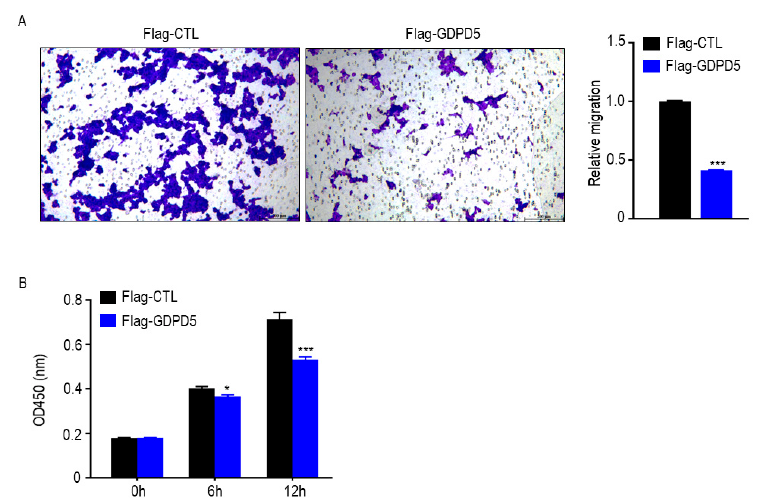
Figure 7. GDPD5 affects the migration and proliferation of human neuroblastoma cell line SH-SY5Y. ( A , B ) GDPD5 effects inhibit the migration ( A , B ) proliferation of SH-SY5Y. *: p < 0.05, ***: p < 0.001.